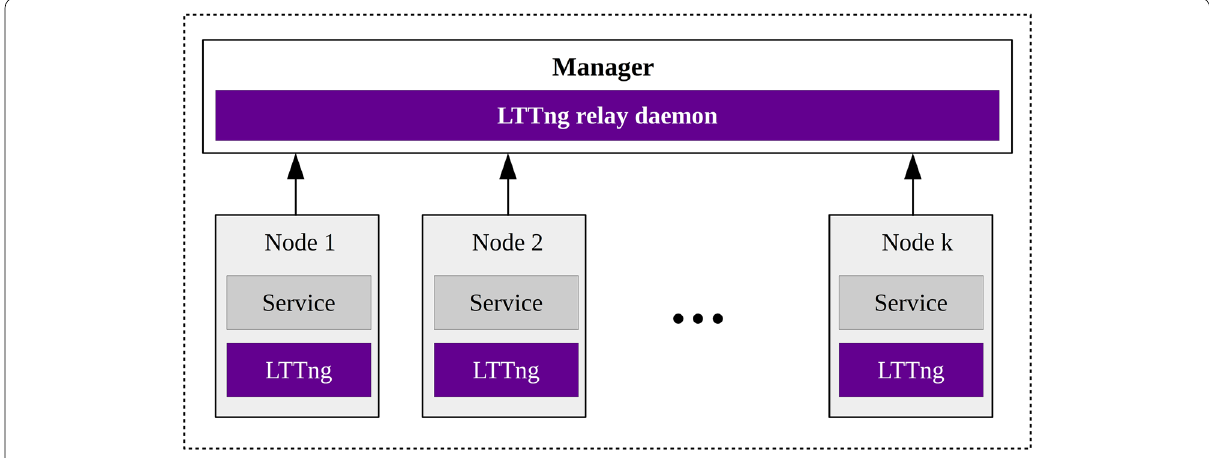
Fig. 2 The overview of our distributed tracing